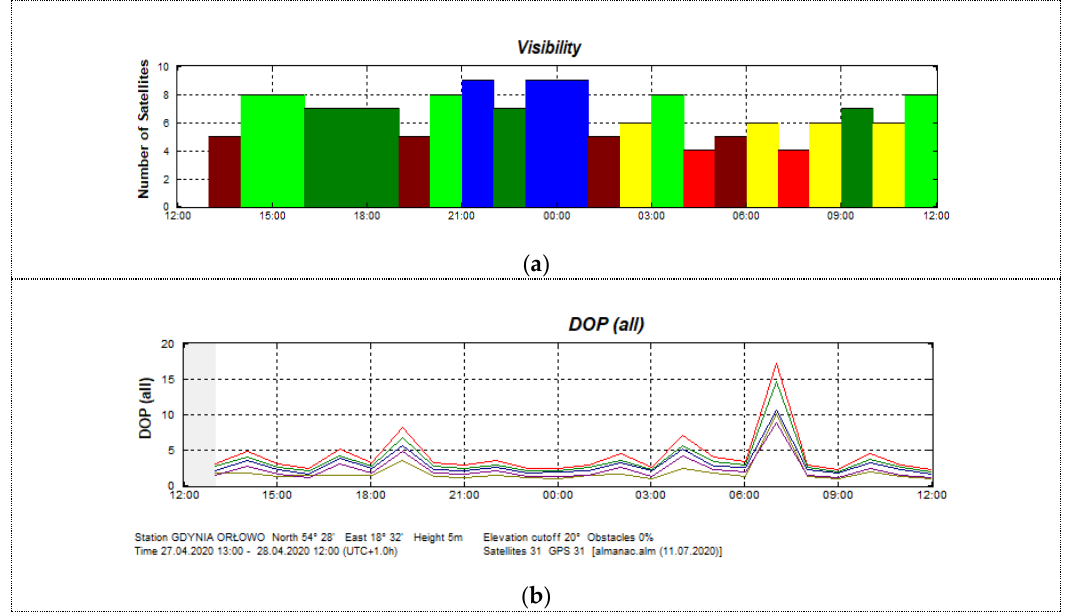
Figure 8. Visibility of satellites ( a ) and dilution of precision coefficients ( b ) in the measurement area on 27–28 April 2020. Notes: Visibility (a): red—4 satellites, brown—5 satellites, yellow—6 satellites, dark green—7 satellites, light green—8 satellites, blue—9 satellites. DOP (Dilution of Precision (b): red—geometrical DOP, green—position DOP, blue—vertical DOP, brown—horizontal DOP, magenta—time DOP. (Source : Trimble Planning 2.9, 2010.).